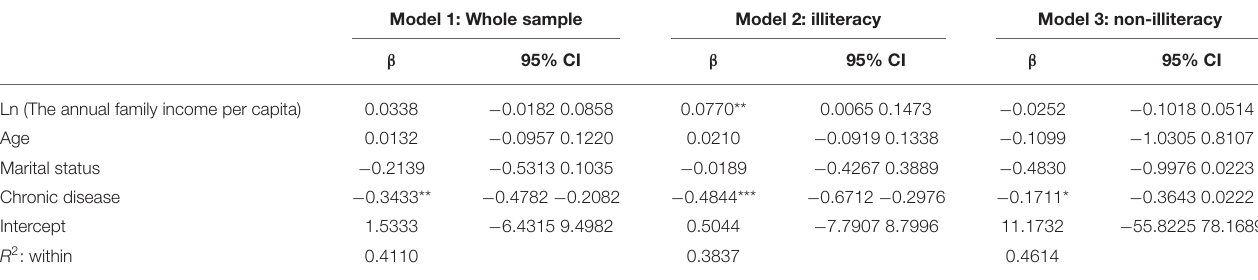
TABLE 2 | Fixed effect modeling of changes in SRH and the annual family income per capita between 2010, 2014, and 2018. Model 1: Whole sample